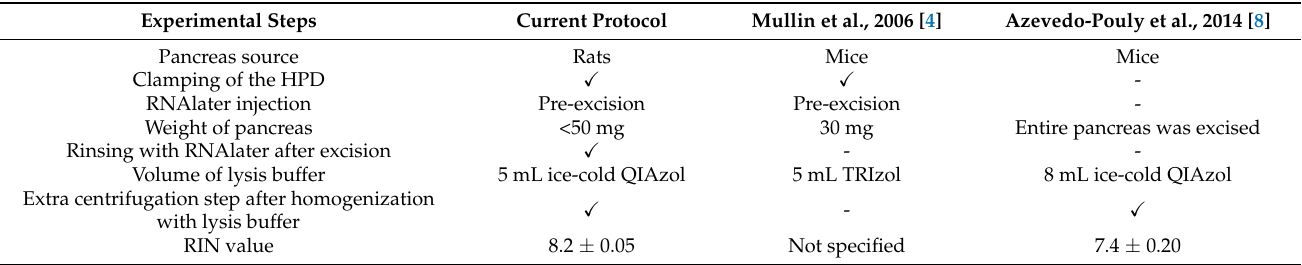
Table 4. Comparison of the experimental steps in the current study with that in two other studies from which the steps were